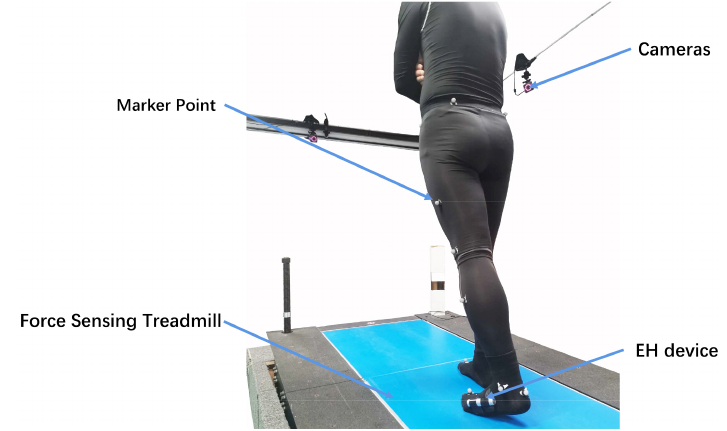
Figure 7. The Vicon motion capture system (Oxford Metrics Limited, England) and force treadmill (AMTI, USA) are used for the measurement of biological torque.